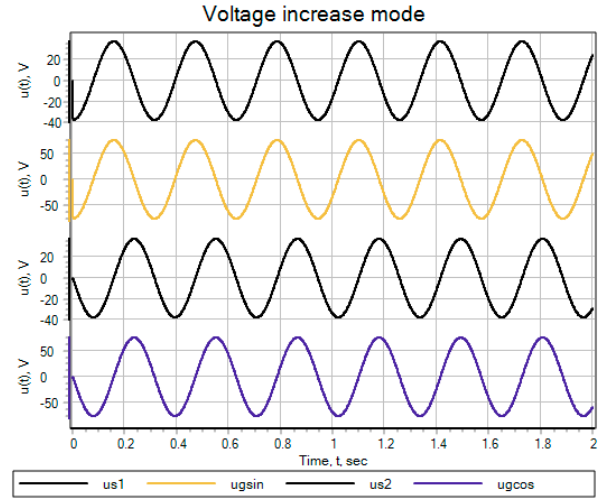
Figure 22. On-load voltage with the stator windings connected in series.